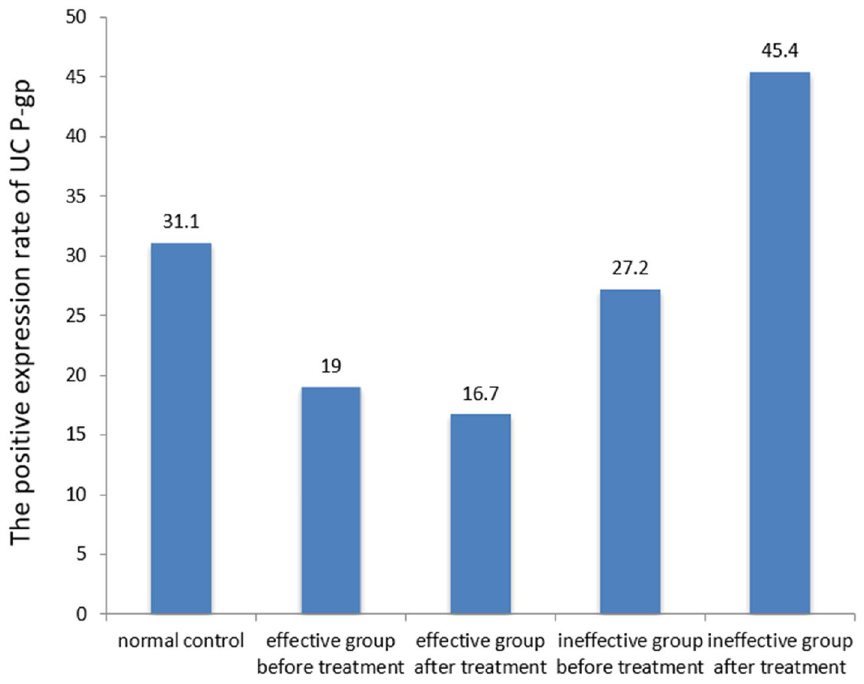
Figure 4. Effect of glucocorticoids on P-gp expression in ulcerative colitis. Calculated from the data in Table 5, shown as mean values. Significant differences between groups are detailed in Table 5.